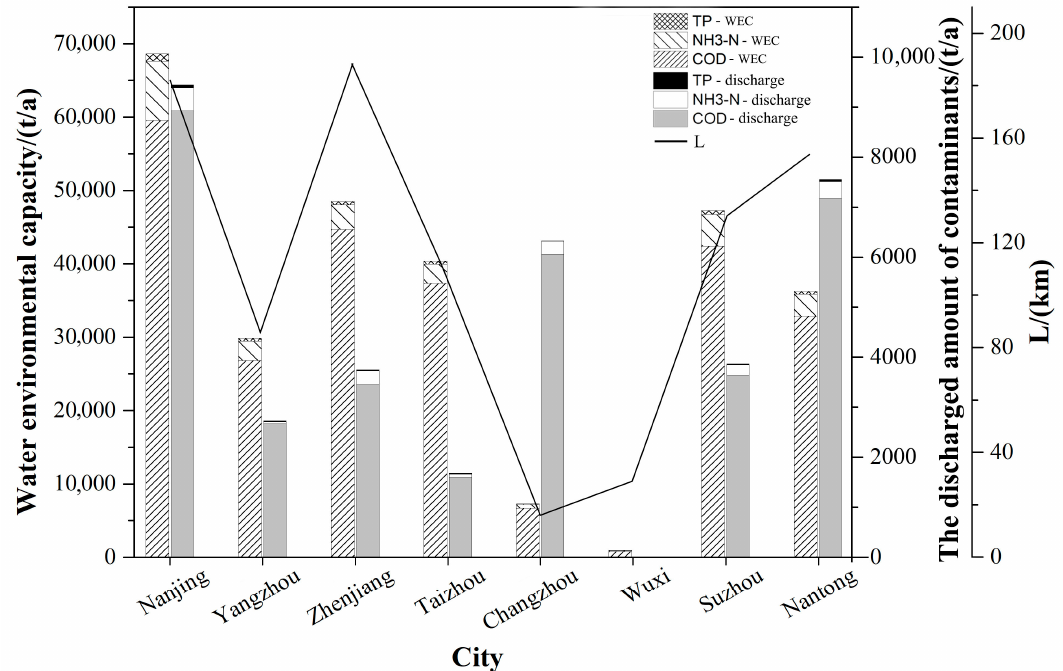
Figure 6. Relationship among the water environmental capacity (WEC) (left bars), the discharged amount of contaminants (right bars), and the maximum longitudinal length of the functional zone (L, solid line). COD Chemical oxygen demand; NH 3 -N Ammonia nitrogen; TP Total phosphorus.